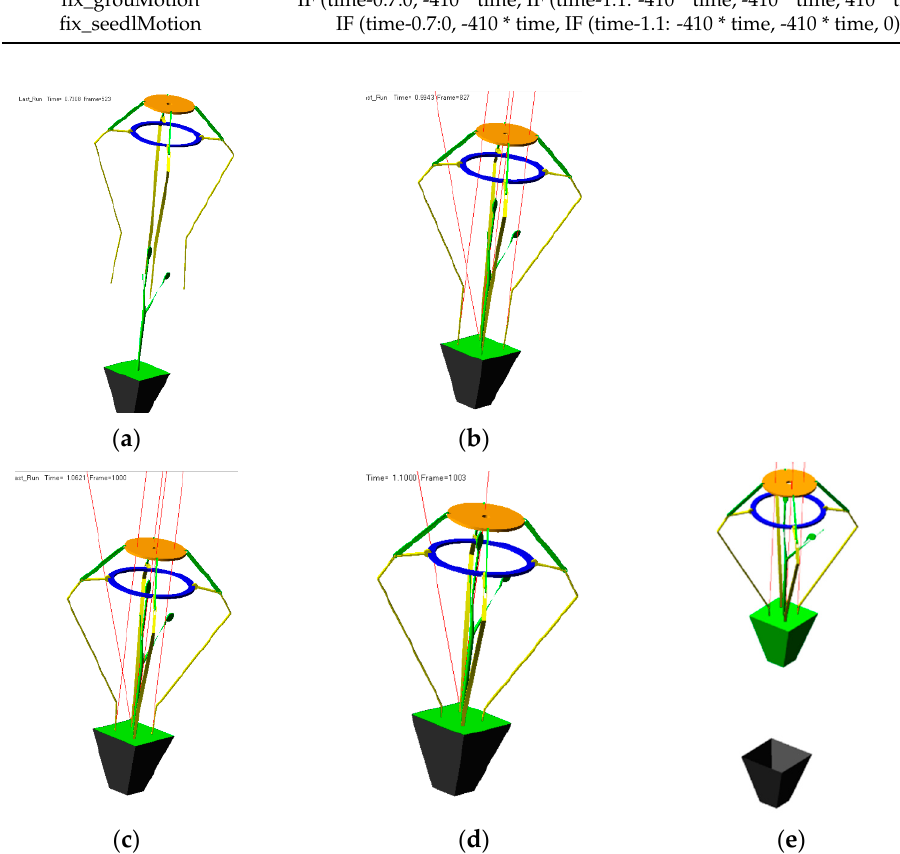
Figure 10. Diagram of seedling pick-up steps. ( a ) Fingers in initial state. ( b ) At the moment of contact. ( c ) Inserting to pot while clamping. ( d ) Achieving required depth. ( e ) Extracting. Table 3. Motion equations of the drive source.